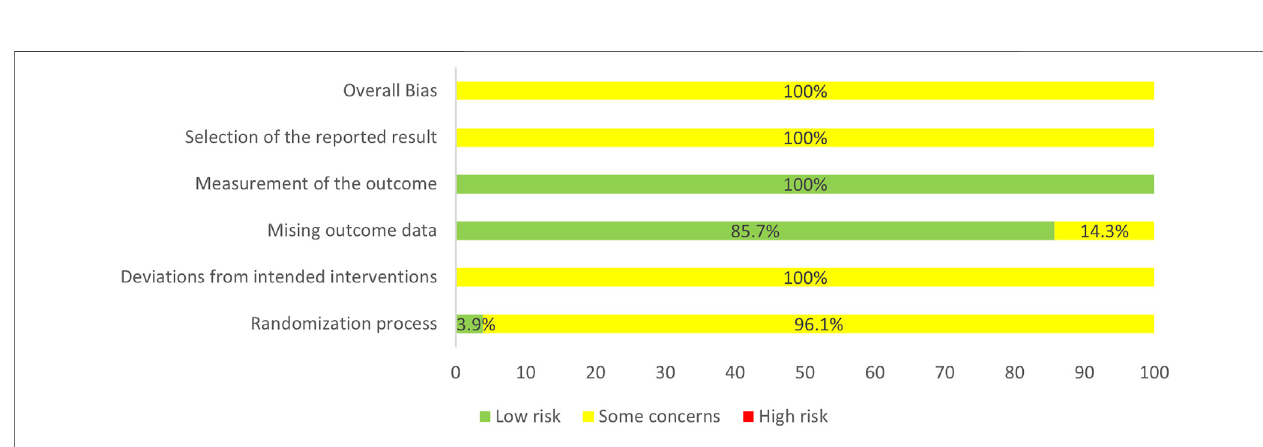
FIGURE 2 | Network graph of different interventions (A) 28-days-motality (B) ICU length of stay (C) Hospital length of stay (D) SOFA score at day 7 after interventions (E) Procalcitonin level at day 7 after interventions (F) Serum lactate level at day 7 after interventions; WM, Western Medicine; SF, Shenfu injection; SM, Shenmai injection; SGM, Shengmai injection; XBJ, Xuebijing injection; YQFM, Yiqifumai injection; DS, Danshen injection; HQ, Huangqi injection; SXT, Shuxuetong injection;SQFZ,Shenqifuzhenginjection;XYP,Xiyanpinginjection. Thenodeswerejoinedbydifferentthicknesslineswhichweregeneratedtoshowwhetherthere existed a direct relationship between treatments and the thickness was weighted according to the available direct evidence between them.